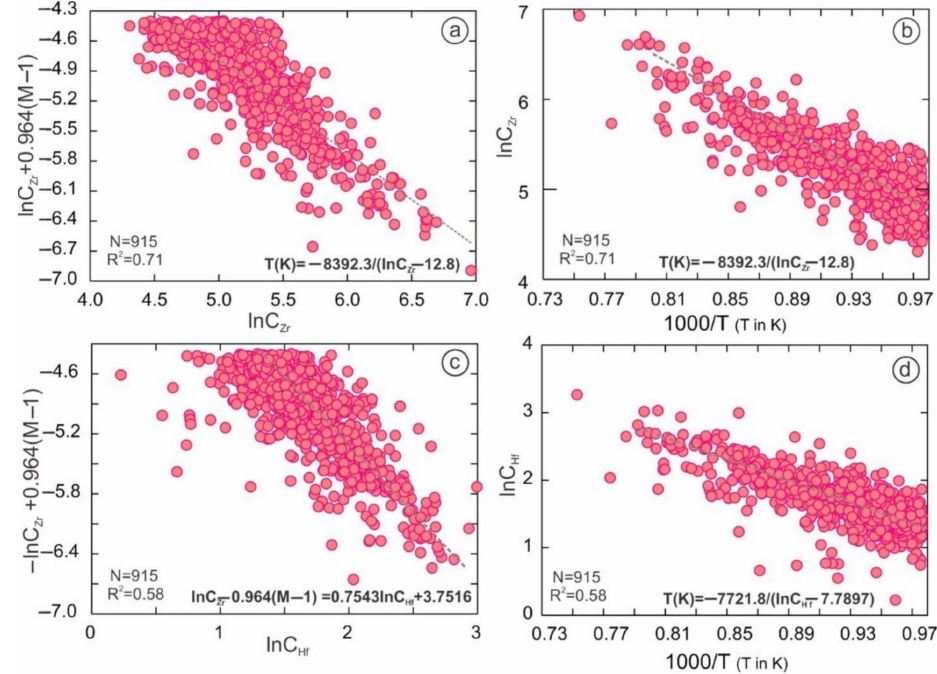
Figure 7. ( a – d ) lnC Zr , lnC Hf vs. − lnC Zr + 0.964(M − 1) and 1000/T (T in K) are plotted for the metaluminous to peraluminous rocks. InC Zr and lnC Hf to lnC Zr + 0.964(M − 1) and 1000/T (T in K) infer a negative correlation (n = 915, and M < 2. http://georoc.mpch-mainz.gwdg.de/georoc/, accessed on 29 August 2021).